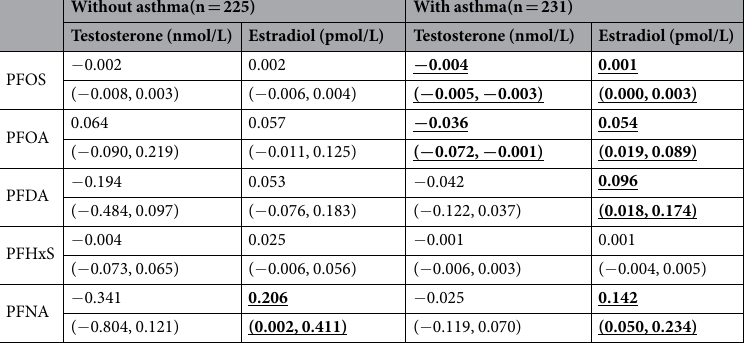
Table 2. Association between PFASs (ng/mL) and ln-(sex hormones) using multivariate linear regression analysis by asthma category. All models are adjusted for age, sex, body mass index, parental education, environmental tobacco smoke exposure, physical activity, and month of survey. Coefficient ( β ) and 95 confidence intervals (CI) represent the change in ln-(sex hormone) levels for each 1 ng/mL increase in PFAS concentration.